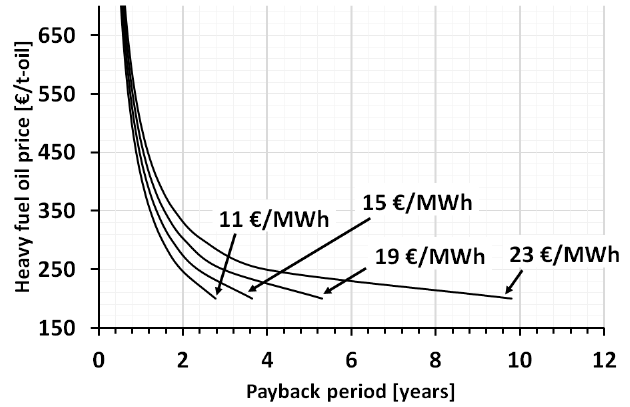
Figure 10. The payback periods when the sawdust prices of 11, 15, 19 and 23 €/MWh are used. The inlet air temperature of the drying air is 80 °C. All other initial values are shown in Table 5.